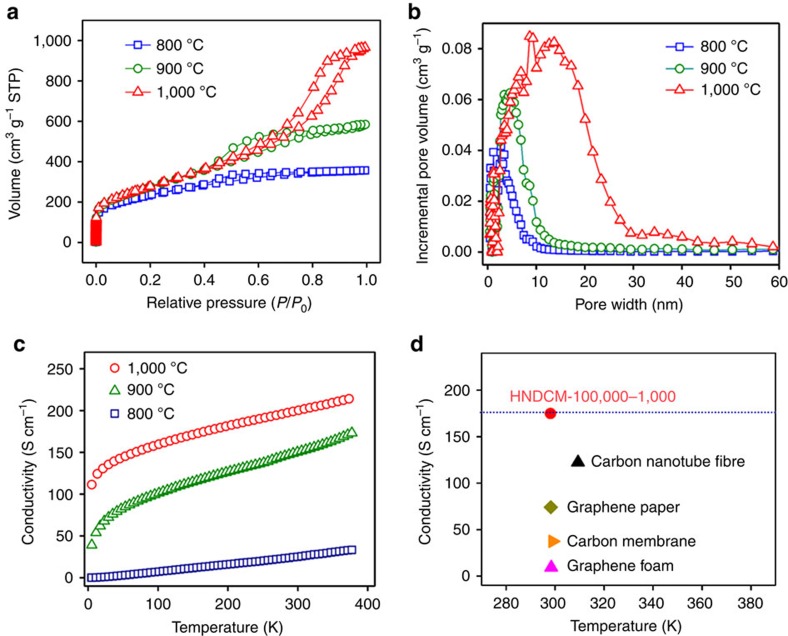
Brunauer–Emmett–Teller specific surface area and conductivity characterizations.(a) N2 absorption–desorption isotherms and (b) corresponding pore size distribution of HNDCM-100,000-1,000/900/800. (c) Temperature dependence of the conductivity measured for HNDCM-100,000-1,000/900/800 from 5 to 390 K using a four-probe method. (d) Comparison of the conductivity of HNDCM-100,000–1,000 with previous results for macroscopic carbon materials (for example, carbon nanotube fibre33, graphene paper34, carbon membrane35 and graphene foam36).